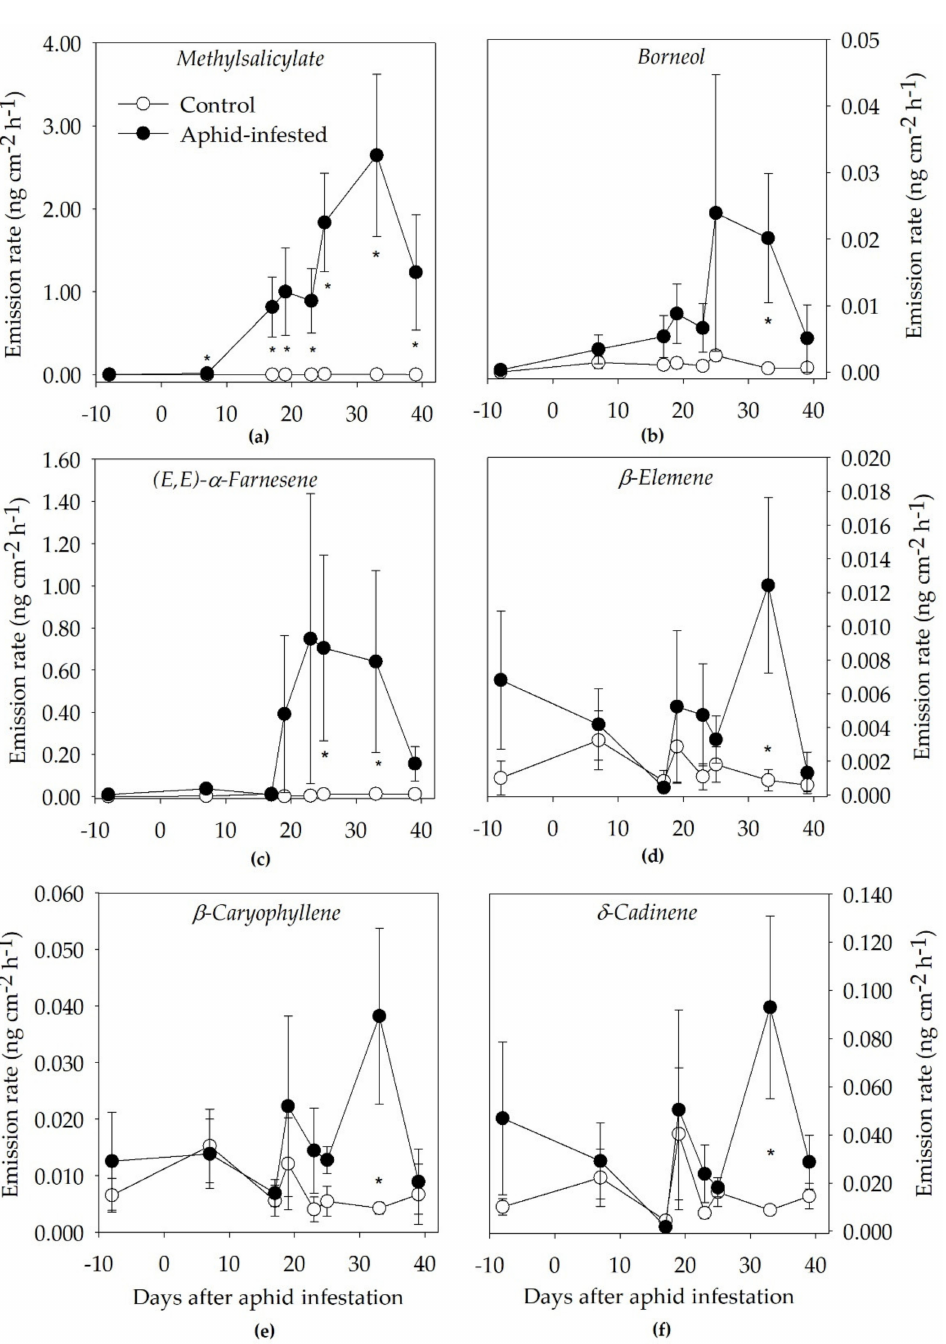
Figure 2. Emission rates (mean ± SE) of ( a ) methylsalicylate, ( b ) borneol, ( c ) ( E,E )- α -farnesene, ( d ) β -elemene, ( e ) β -caryophyllene and ( f ) δ -cadinene from Scots pine branch tips before and after aphid infestation in Experiment 1. Day 0 refers to aphid infestation. Stars indicate significant ( P < 0.05) di ff erences between control ( n = 6) and aphid-infested ( n = 6)